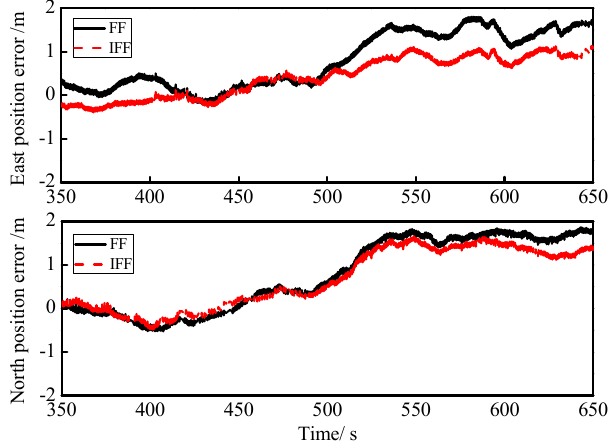
Figure 12. Curves of the east and north position errors for FF and IFF. Table 8. RMSEs of the positions (m) for FF and IFF.